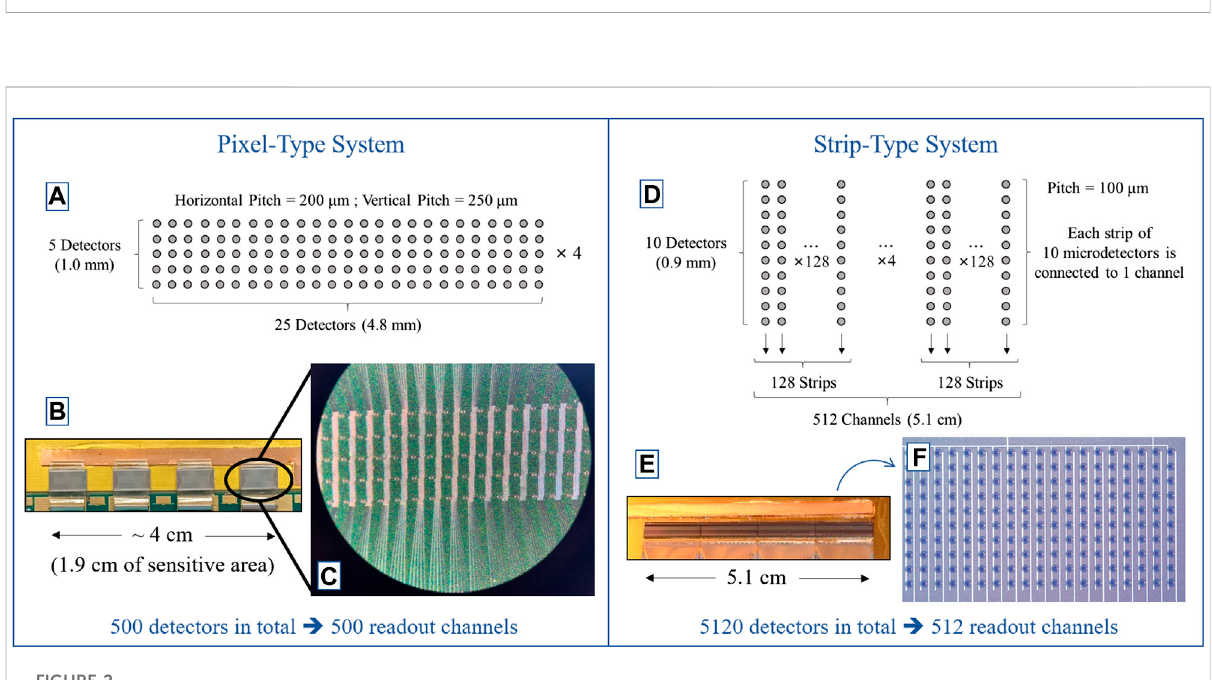
FIGURE 2 (A) Sketch of the 25 × 5 pixel-type layout. (B) Optical image of the four pixel-type arrays. (C) Detail of the array:each detector is connected to a ROC channel. (D) Sketch of the strip-type arrays. (E) Photograph of the 4 strip arrays stacked laterally covering a 5.1cm length without gaps. The pitch-adapters connecting the individual strips with the corresponding ASICs are partially shown at the bottom. (F) Optical image of some of the 10 microdetector